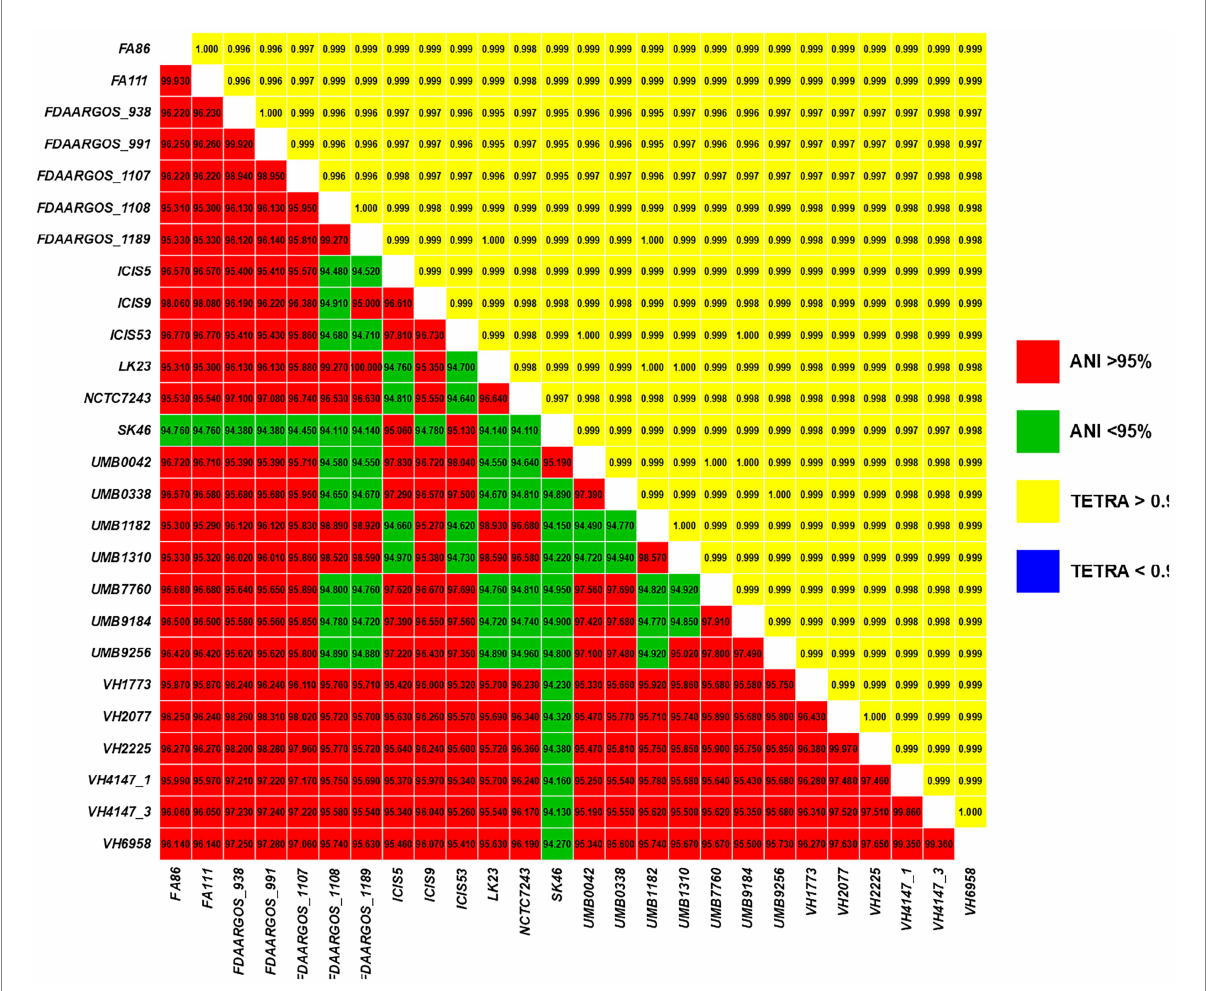
FIGURE 1 Pairwise comparisons of ANIb values (bottom triangle) and TETRA values (upper triangle) between all studied C. amycolatum genomic